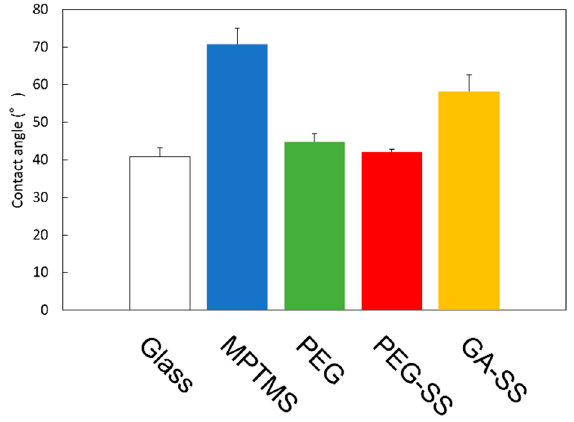
Figure 3. Contact angles. Error bars show standard deviations.